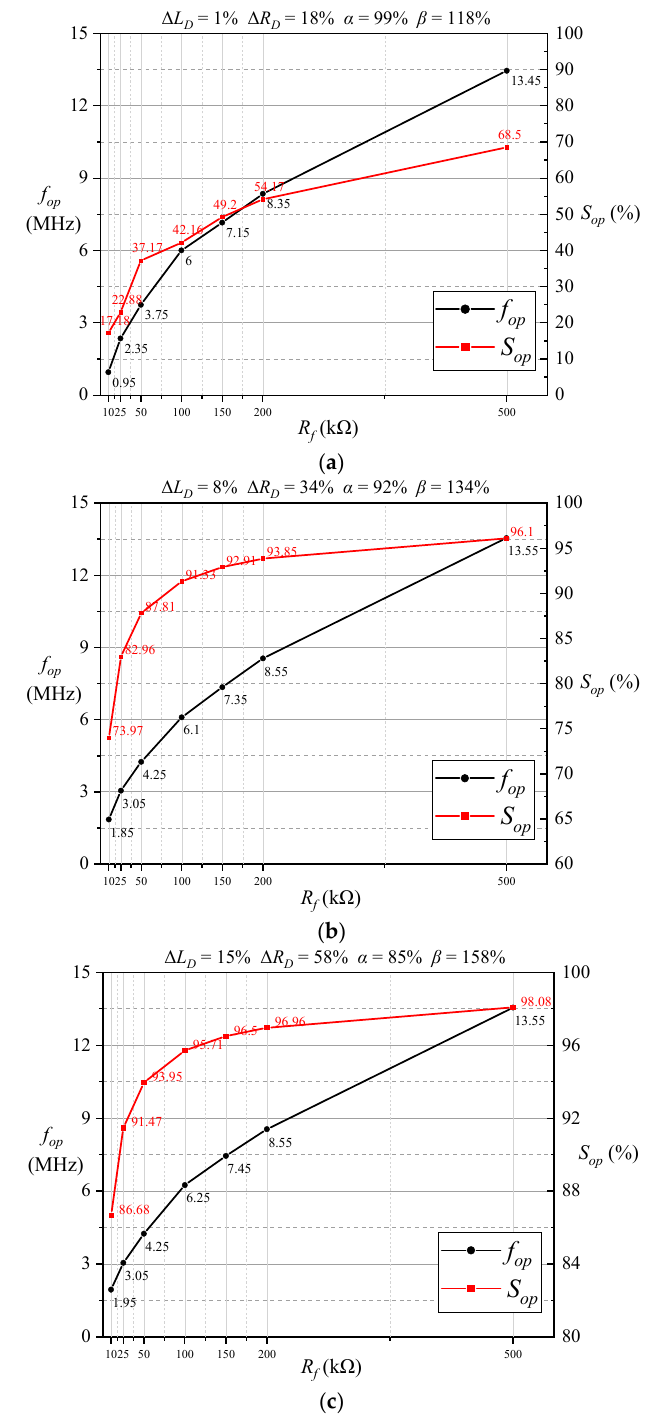
Figure 6. The optimal frequency f op and its corresponding optimal detection sensitivity S op with dif- ferent R f : ( a ) Δ L D = 1%, Δ R D = 18%, α = 99%, β = 118%; ( b ) Δ L D = 8%, Δ R D = 34%, α = 92%, β = 134%; ( c ) Δ L D = 15%, Δ R D = 58%, α = 85%, β = 158%.